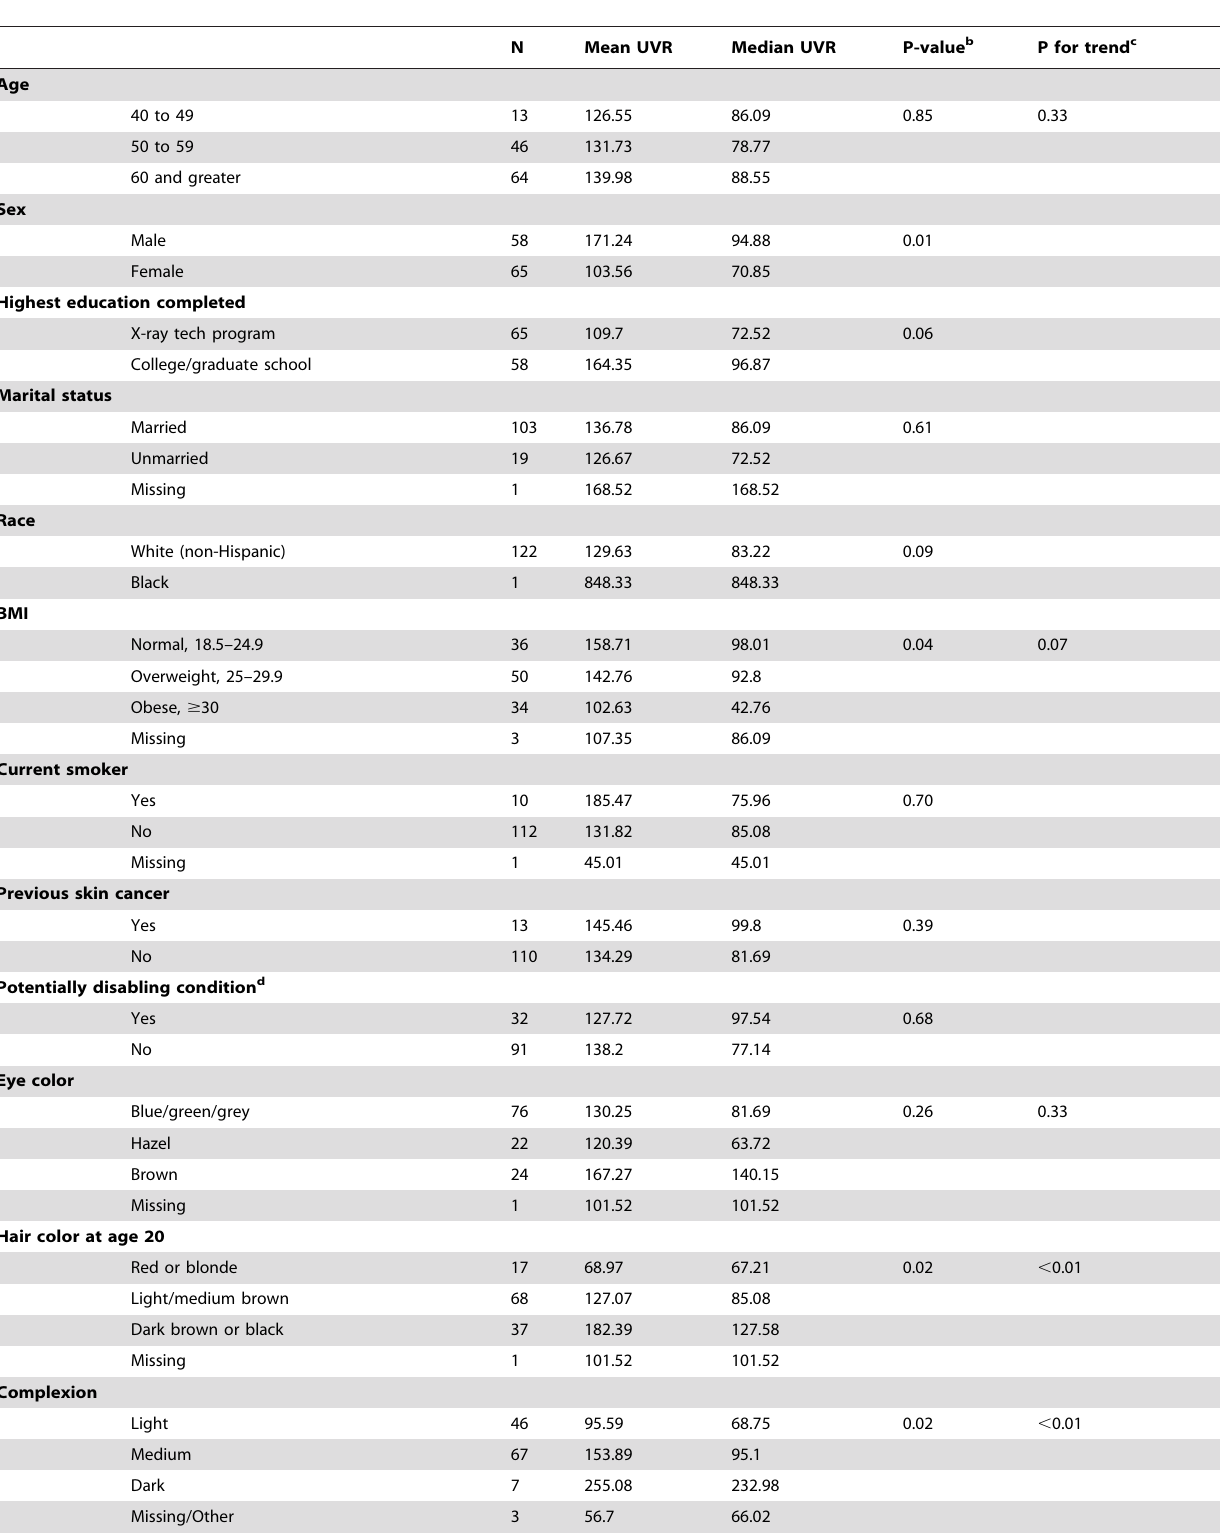
Table 1. Distribution of average daily personal UVR (J/m 2 ) across individual factors for 123 participants from the United Radiologic Technologists’ study.